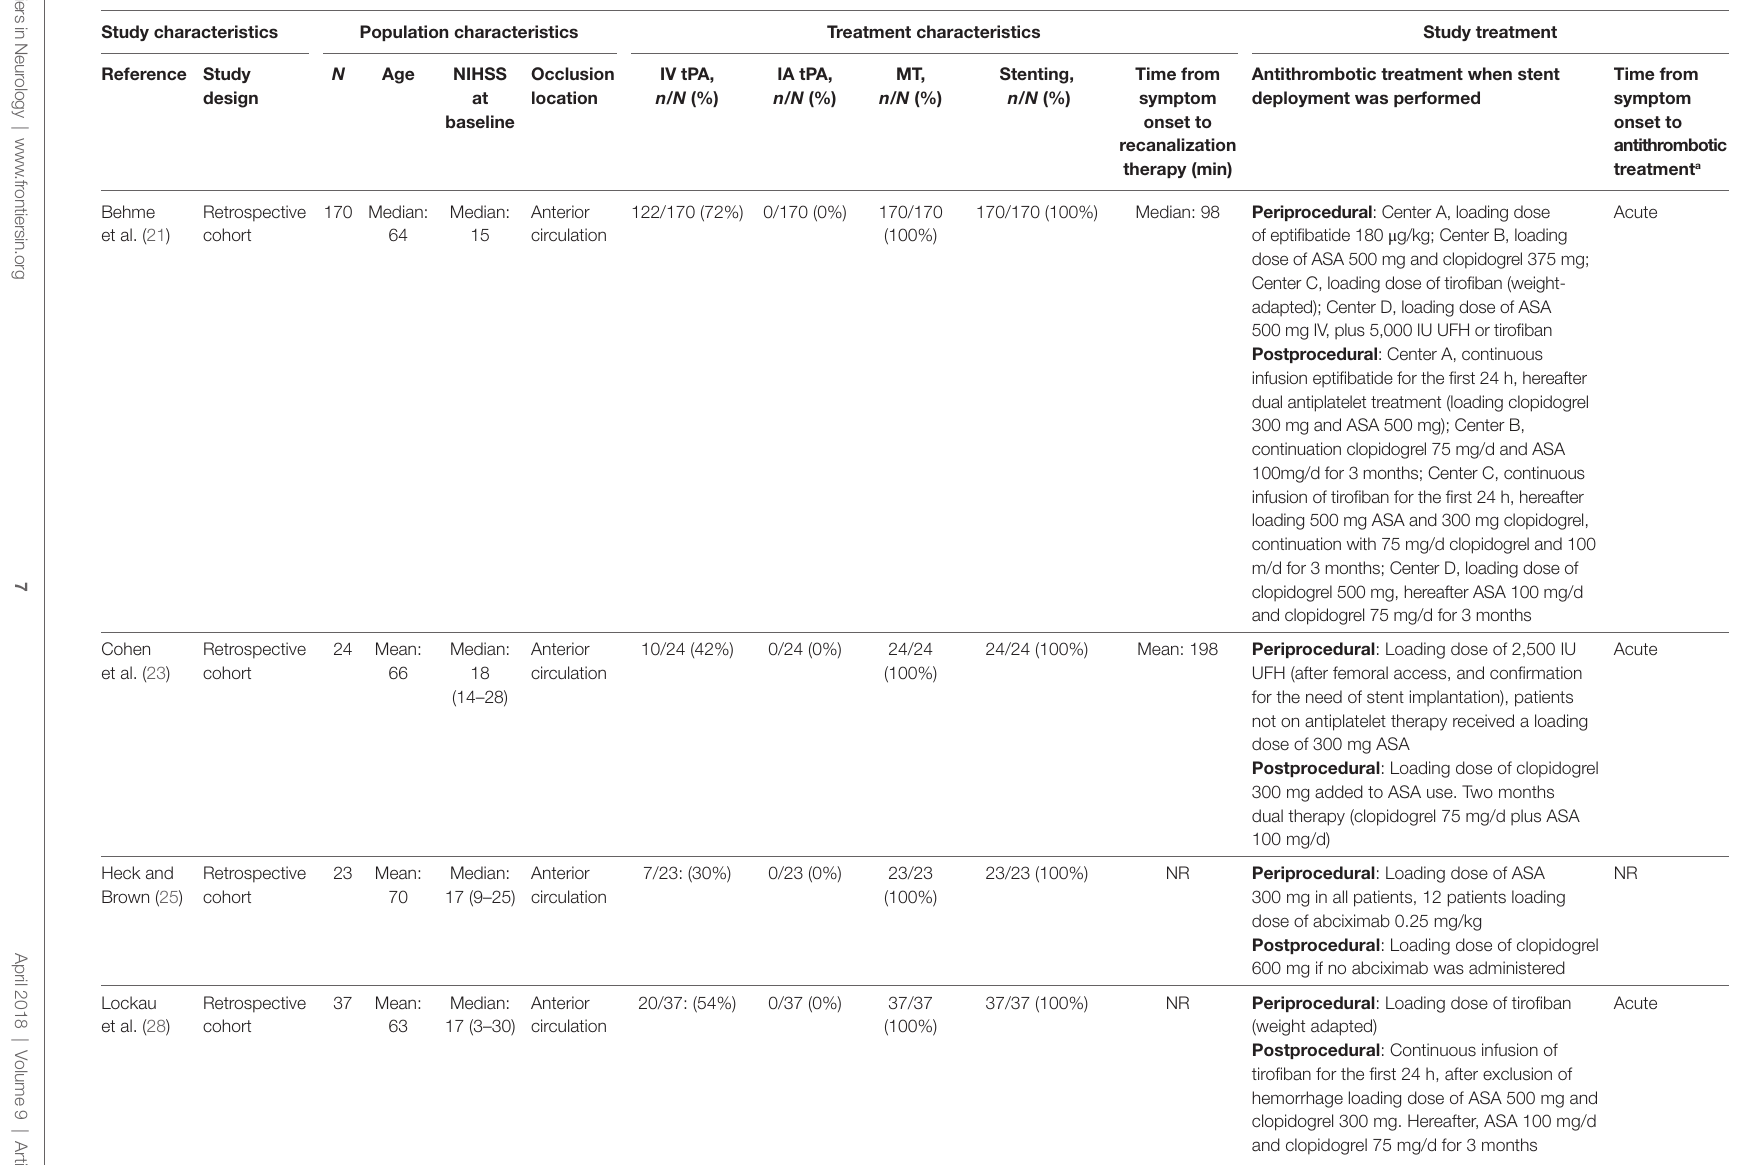
taBLe 3 | Characteristics of included studies investigating patients with ischemic stroke caused by a “tandem lesions” who underwent acute MT with or without emergency extracranial carotid stenting, who received periprocedural antithrombotic drugs as protocol-based